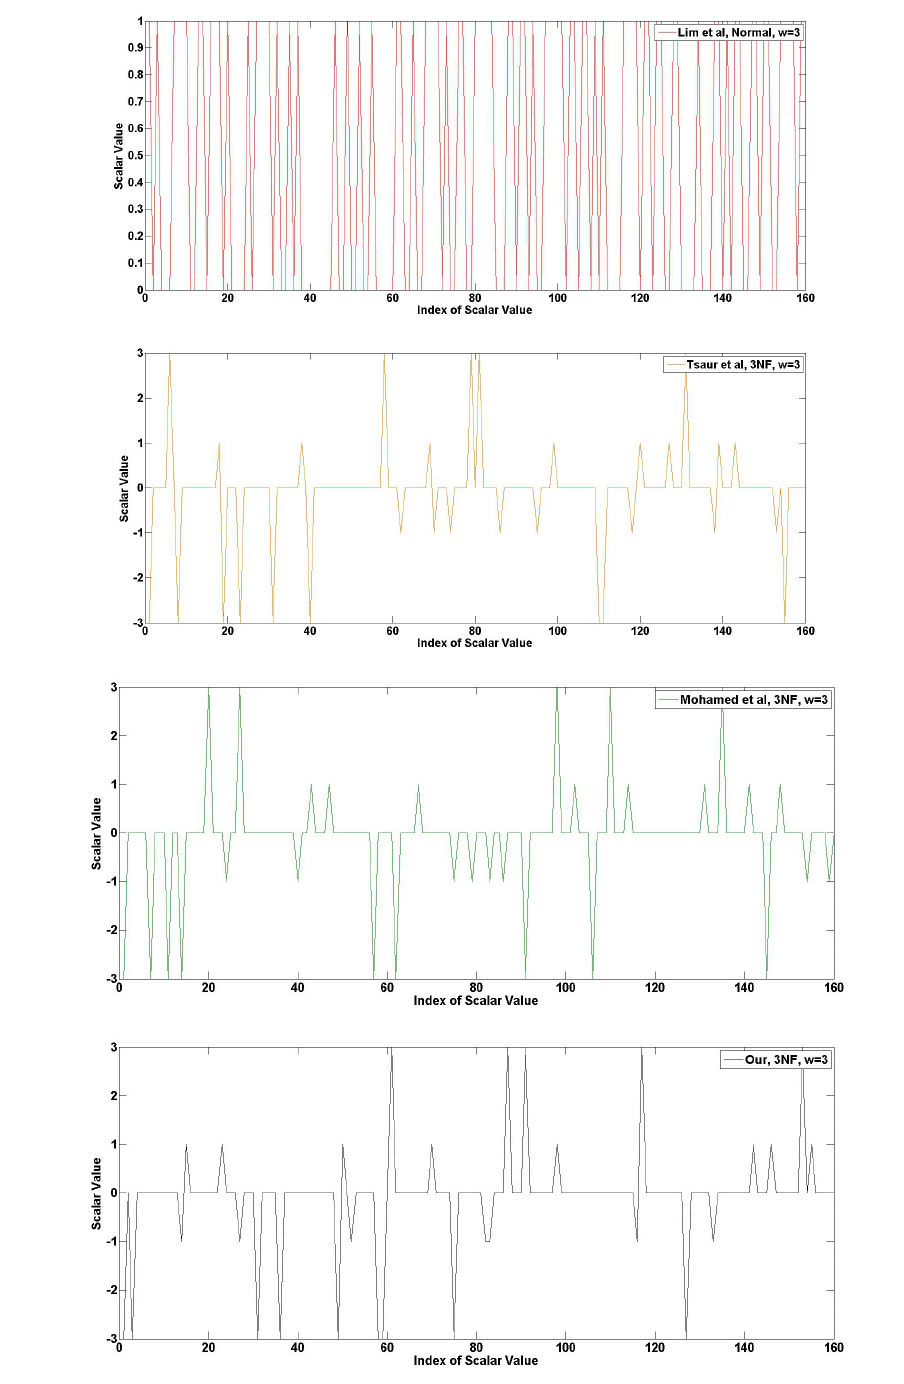
Figure 15. Frequency of scalar value represented in